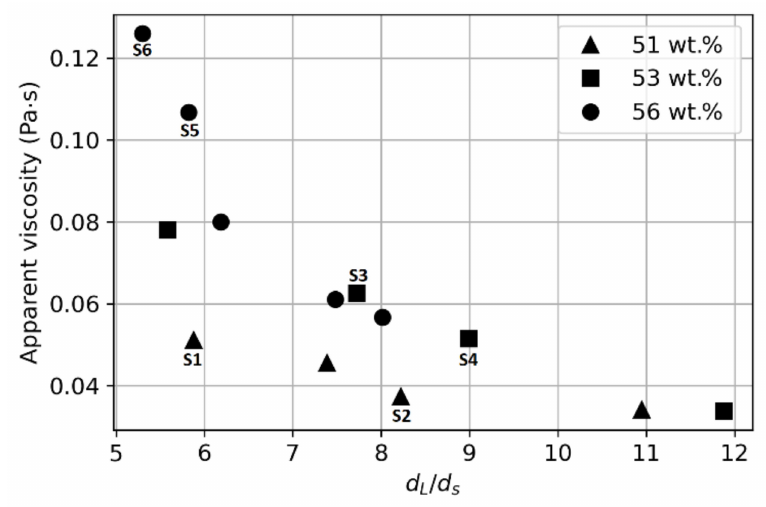
Figure 7. Apparent viscosity at a constant shear rate of 400 s − 1 as a function of the D -value ratio of the large ( d L ) and small ( d S )